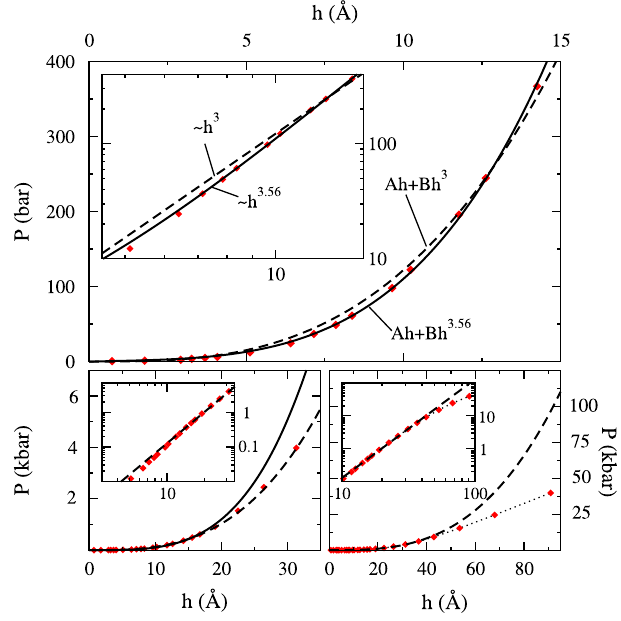
Fig. 3 Pressure as a function of the midpoint de fl ection obtained from simulations ( symbols ) on three different de fl ection ranges. The solid line is a best fi t according to Eq. 12 over the interval h ∈ [0, 15] Å, while the dashed lines are best fi ts according P = Ah + Bh 3 over the interval h ∈ [0, 15] Å ( upper panel ) and h ∈ [15, 35] Å ( lower panels ), respectively. These insets are the same plots in log – log The upper panel in Fig. 3 shows that, for pressures up to ~400 bar, the simulation data are in good agreement with Eq. 12, as shown by the best fi t ( solid line ), and clearly deviate from a best fi t based on P = Ah + Bh 3 , expected without renormalization of the elastic constants. Instead, beyond 400 bar up to about 6000 bar shown in the left bottom panel, the data points are best fi tted by P ¼ Ah þ Bh 3 ’ Bh 3 , which according to our analysis should apply for P > P c 3 . This suggests that P c 3 ’ 400 bar, about a factor 2 smaller than the estimate from Eq. 11 (see also Fig. 1) but are ignored in the theoretical derivations. The best fi t for pressures in the range [400 – 40,000] bar, beyond